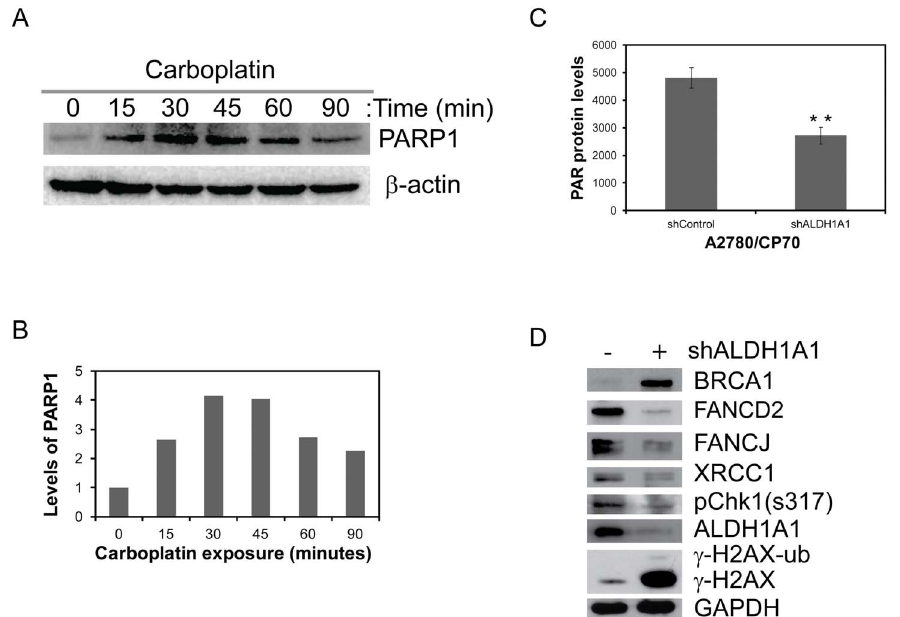
Figure 6. ALDH1A1 status alters cell cycle checkpoints and DNA repair networks. ALDH1A1 proficient (control) and deficient (shALDH1A1) A2780/CP70 cells were assessed for their abilities to repair carboplatin induced single strand breaks by looking at time dependent induction of PARP- 1 protein levels by western blots (A), densitometry of blots by Image J (B) and total PARP activity was assayed by measuring PAR levels (C). To assess the ALDH1A1 dependent expression DDR and repair proteins, whole cell lysates were normalized for total proteins and western blot analysis were performed using antibodies as represented (D).